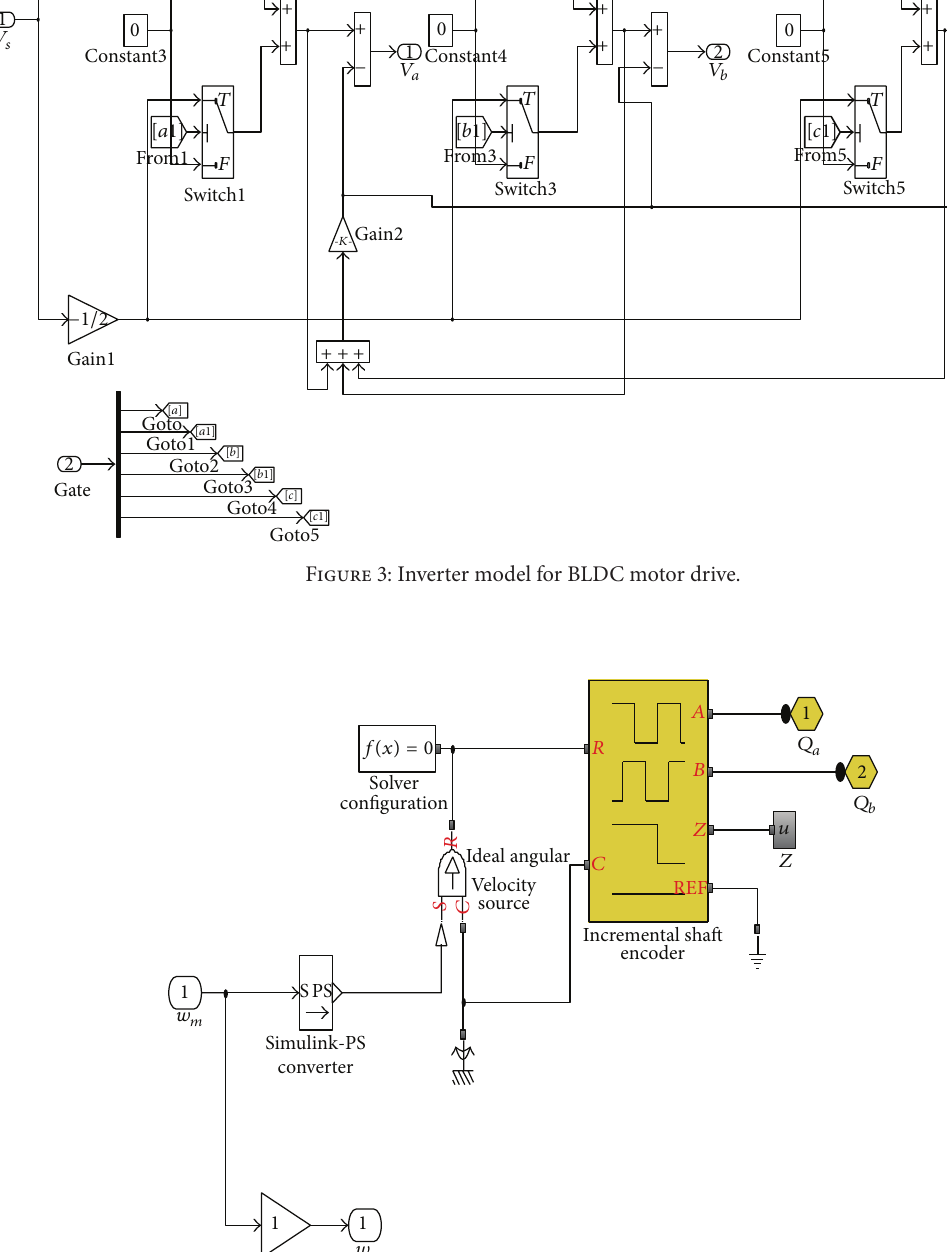
Figure 4: Encoder model for BLDC motor